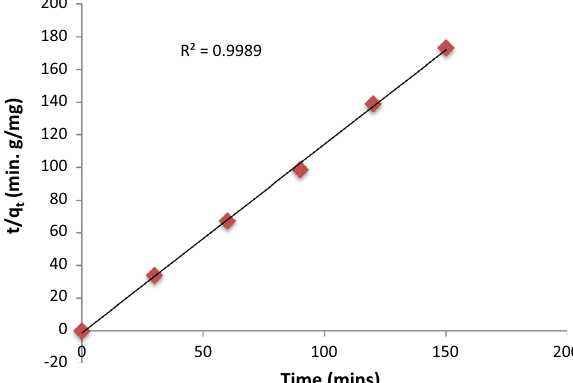
Fig. 11 Pseudo-second-order plot on sorption of Yokri crude oil unto FBPC